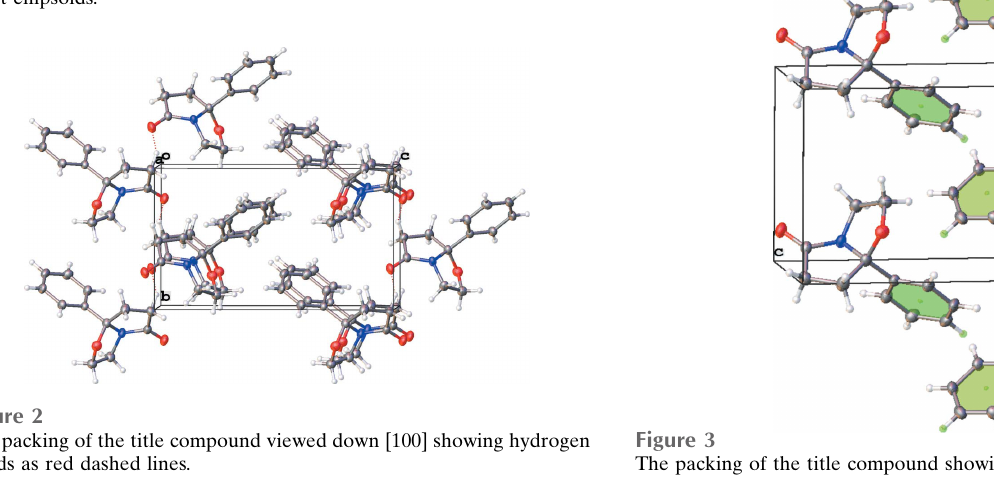
Figure 1 The molecular structure of the title compound showing 50% displace- ment